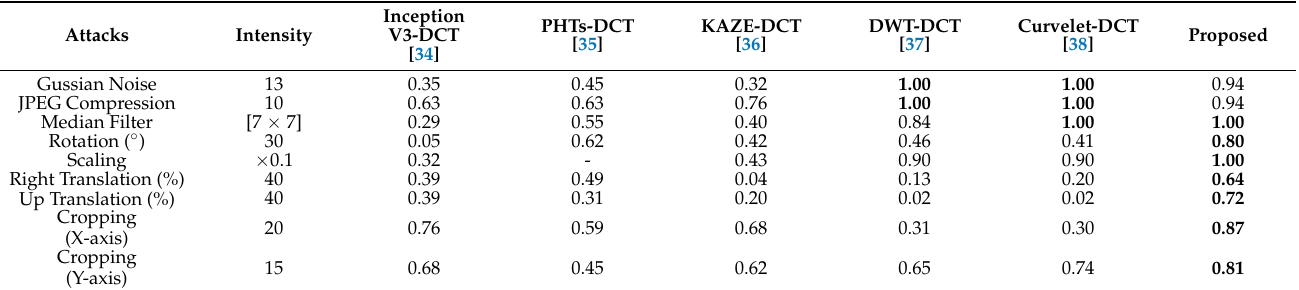
Table 5. Comparison of NC values between different